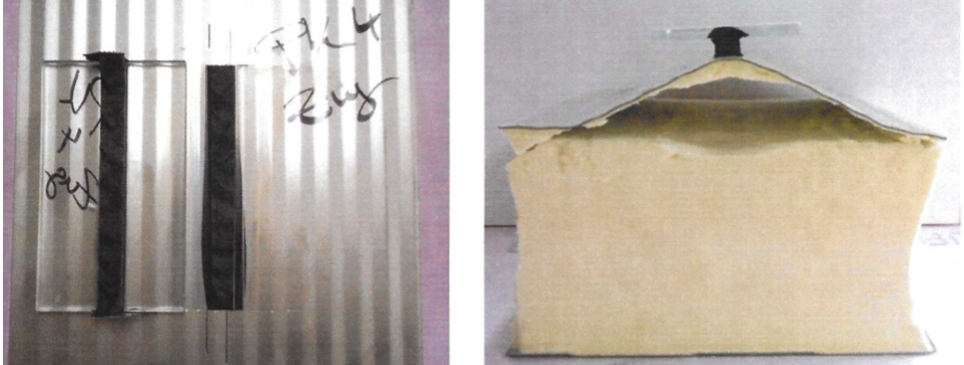
Fig. 6 Cohesive failure of silicone joint (right) and tensile failure of PUR core (left).